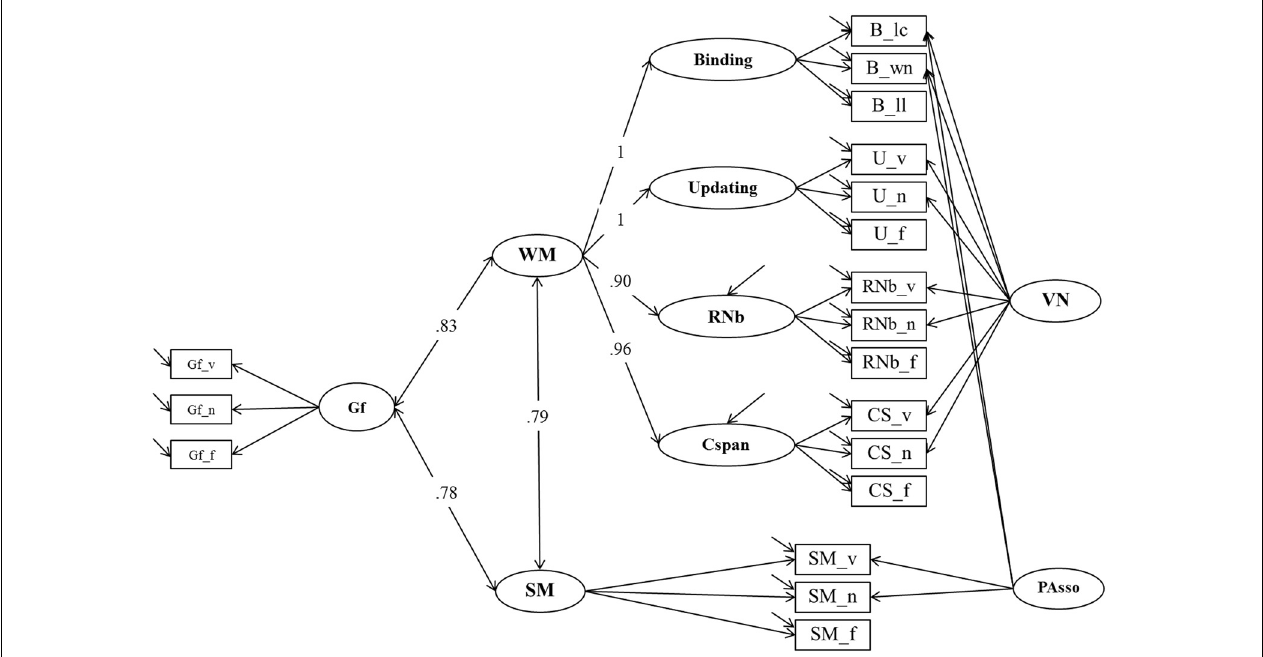
FIGURE 8 | Structural Equation Model testing the relationship of WM, SM and Gf (Model 5). Binding, Updating, Recall 1-back (RNb) and Complex Span (Cspan); VN, Verbal-Numerical Content Factor; SM, Secondary